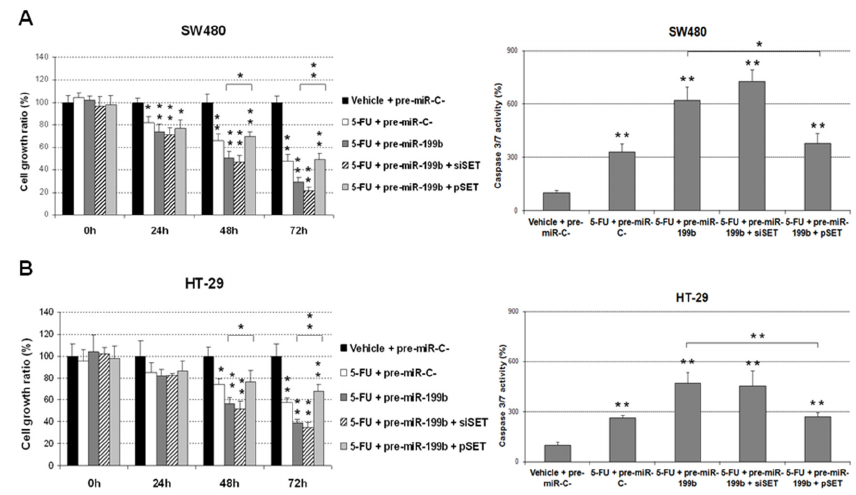
Figure 2. MTS and caspase 3/7 assays showing the effects of an ectopic SET modulation in miR-199b-dependent 5-FU resensitization in ( A ) SW480 and ( B ) HT-29 cells; * p < 0.05; ** p < 0.01.